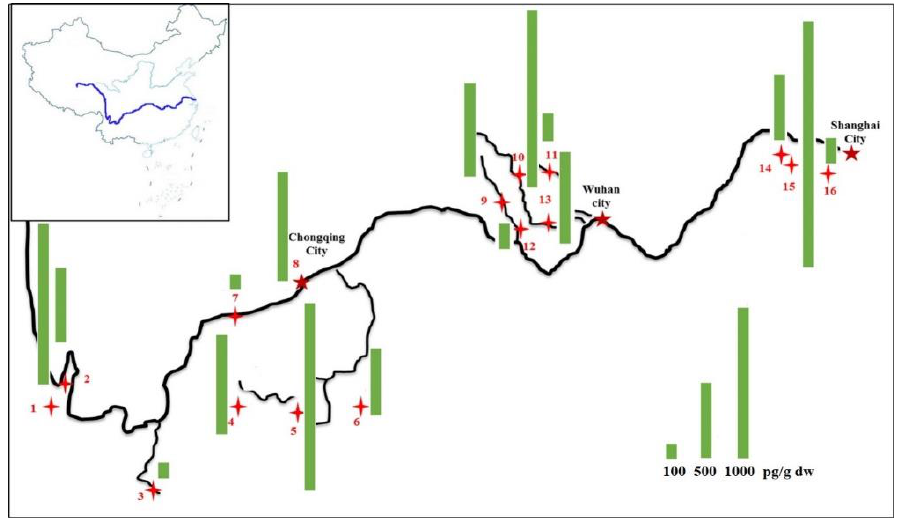
Figure 1. The PCN concentrations of the sampling sites from the Yangtze River Basin. The PCN concentrations in the sediment samples ranged from 0.103 to 1.631 ng g −1 . The lowest concentration of PCNs was found at S7 located in Minjiang River which was served as a water reservoir. The highest concentration of PCNs was found at S15, collected from Xijiu River in Yixing City, a residential urban area. In the upstream zone (samples S1–S3), the relatively higher PCN concentration was found at S1 located near a famous tourist resort. Among the upper- and middle-stream zone samples, the PCN concentrations of S8 and S5 were relatively high. This was mainly due to the fact